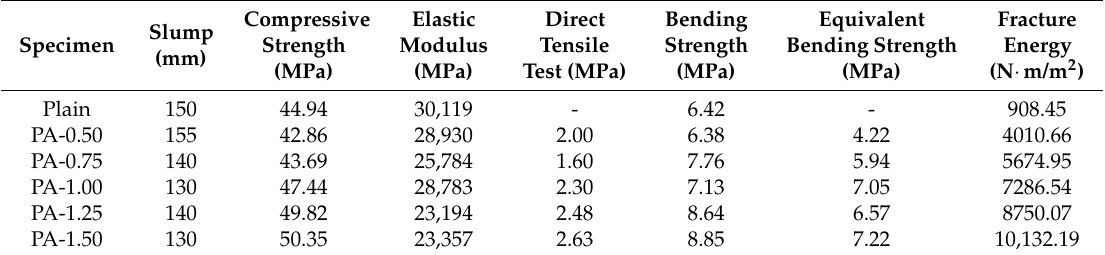
Table 2. PAFRS mechanical properties.